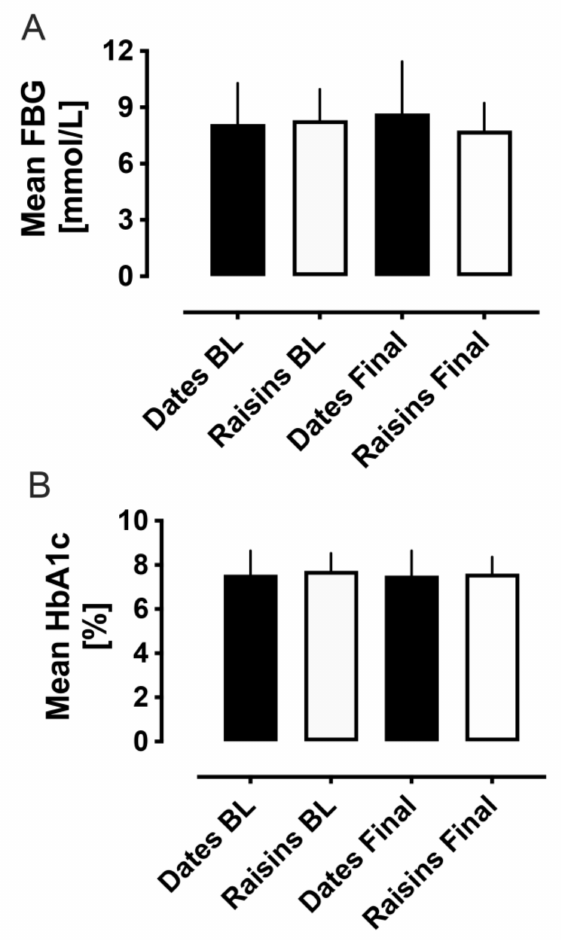
Figure 2. Fasting blood glucose (FBG, laboratory measurement) ( A ) and HbA1c ( B ) comparisons between baseline and at the end of the 12-week trial period. FBG and HbA1c levels showed no between or within group changes for either the date fruit or the raisins groups. BL,